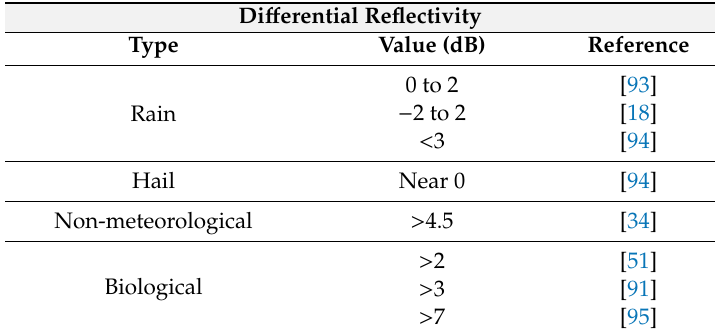
Table A4. Examples of di ff erential reflectivity values for di ff erent types of